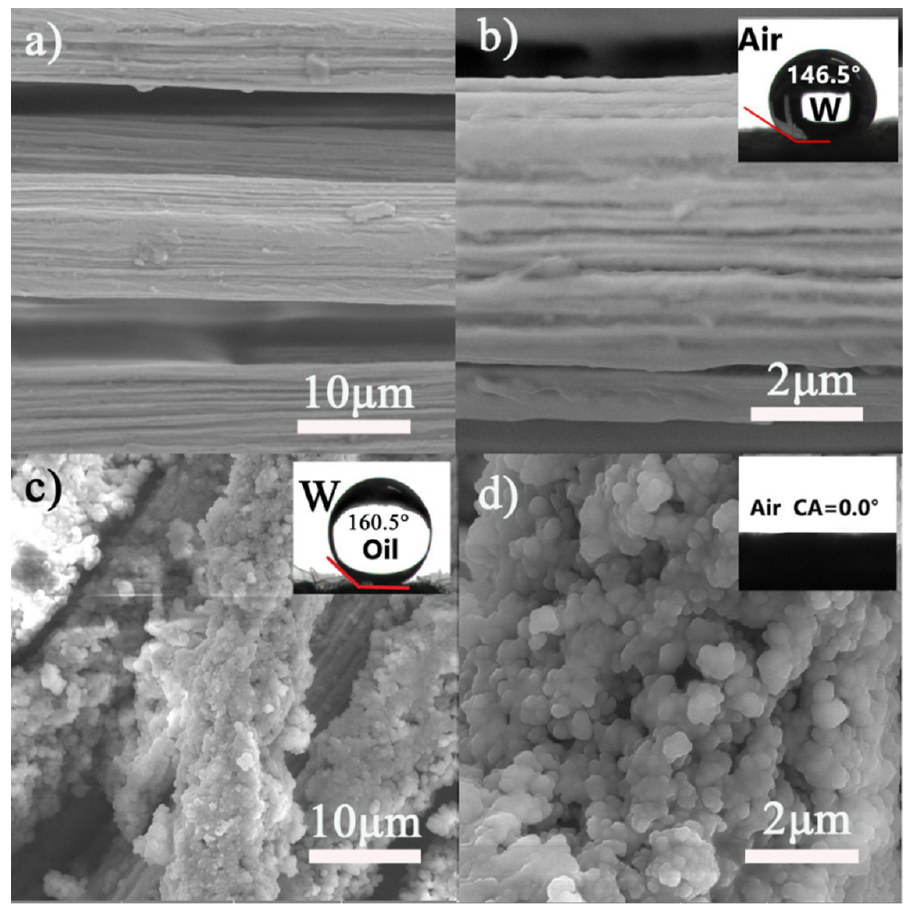
Figure 1. SEM images of ( a , b ) original stainless steel fibers (SSF) and SiO 2 -Na 2 SiO 3 -coated ( c , d ) SSF. The insets show the contact angle ( b ) of raw SSF, treated underwater oil contact angle ( c ) and water contact angle ( d ) in air.